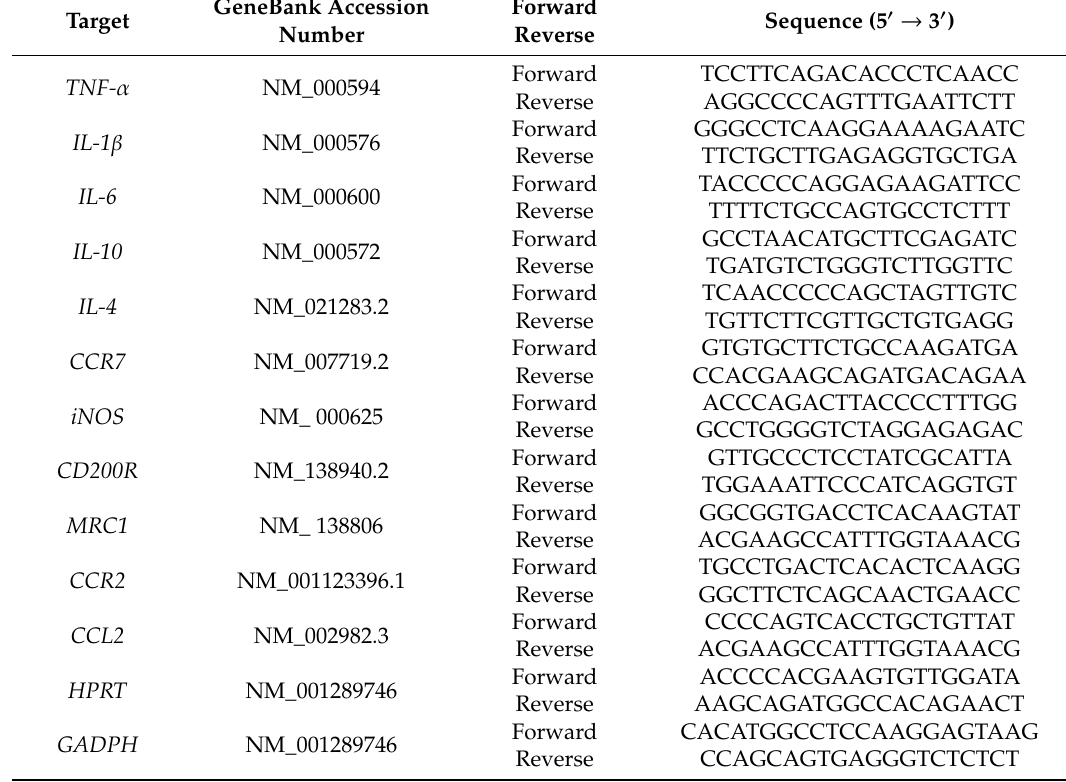
Table 1. Primer sequences for RT-qPCR gene expression